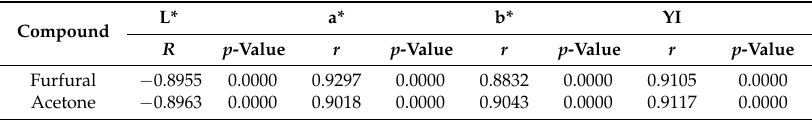
Table 3. Pearson correlation coefficients (r) between color parameters and furfural and acetone content in sweet